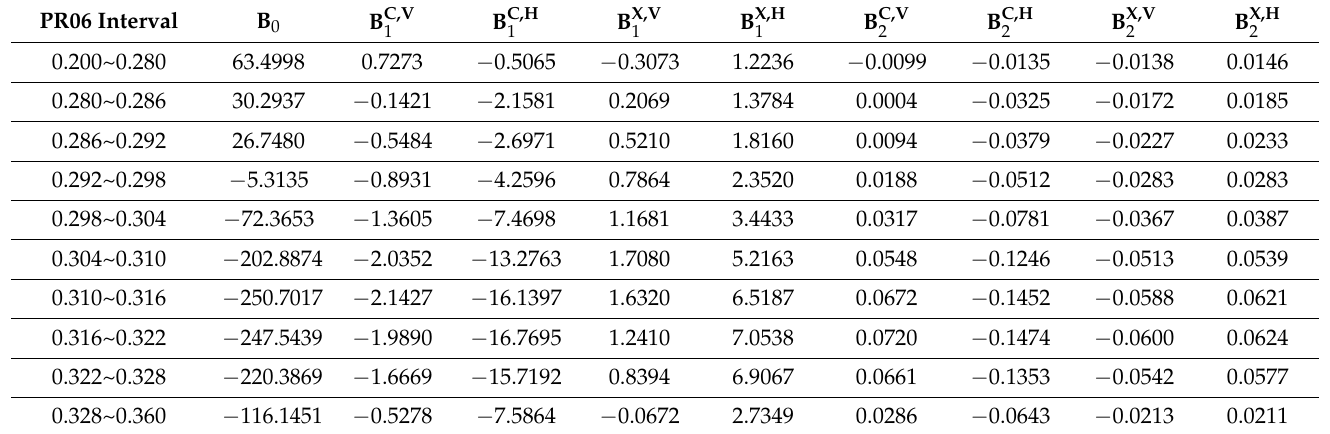
Table 4. The coefficients of Equation (10) for the wind speed retrieval